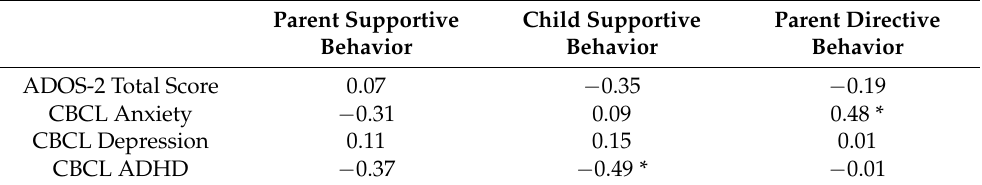
Table 4. Pearson Correlations Between IFIRS and Characteristics of Children on the Autism